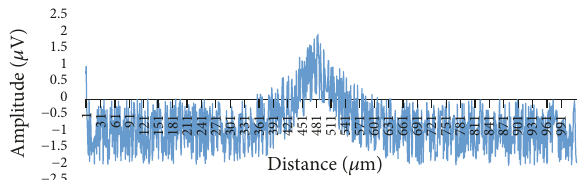
Figure 4: Signal of potential SVET immersed in a noise environ- ment with a SNR of 9.03 dB.